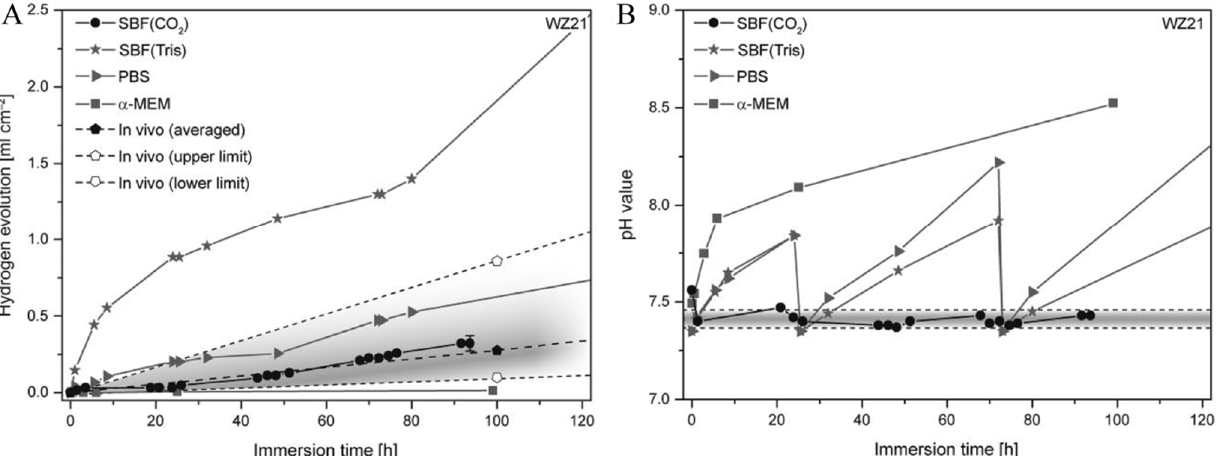
Figure 4. In vitro degradation performance for an SBF-CO 2 WZ21 alloy, which is in agreement with the average in vivo degradation rate based on µCT (computed tomography) data. The pH values remained mostly constant [140] . ( A ) H2 evolution over time of WZ21 immersed in different physiological media; ( B ) Corresponding pH values evolution in the testing solutions over immersion time